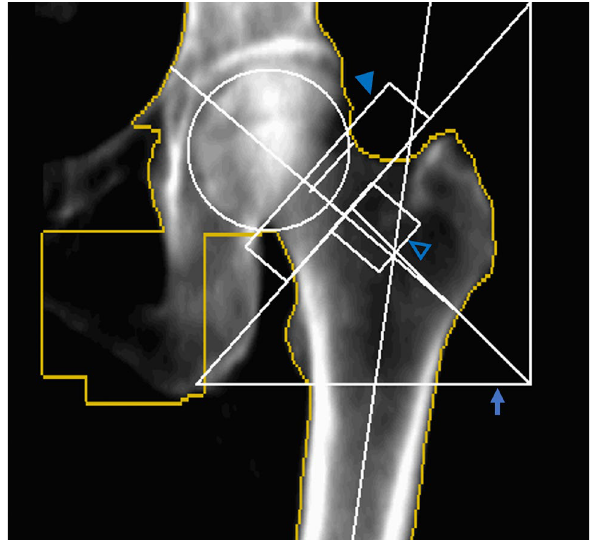
Figure 1. BMD was measured with DXA in the contralateral hip. ROI for the femoral neck (solid arrowhead), ward’s triangle (hollow arrowhead), and trochanter (arrow) are shown. ROI for the total hip is sum of the three ROIs.